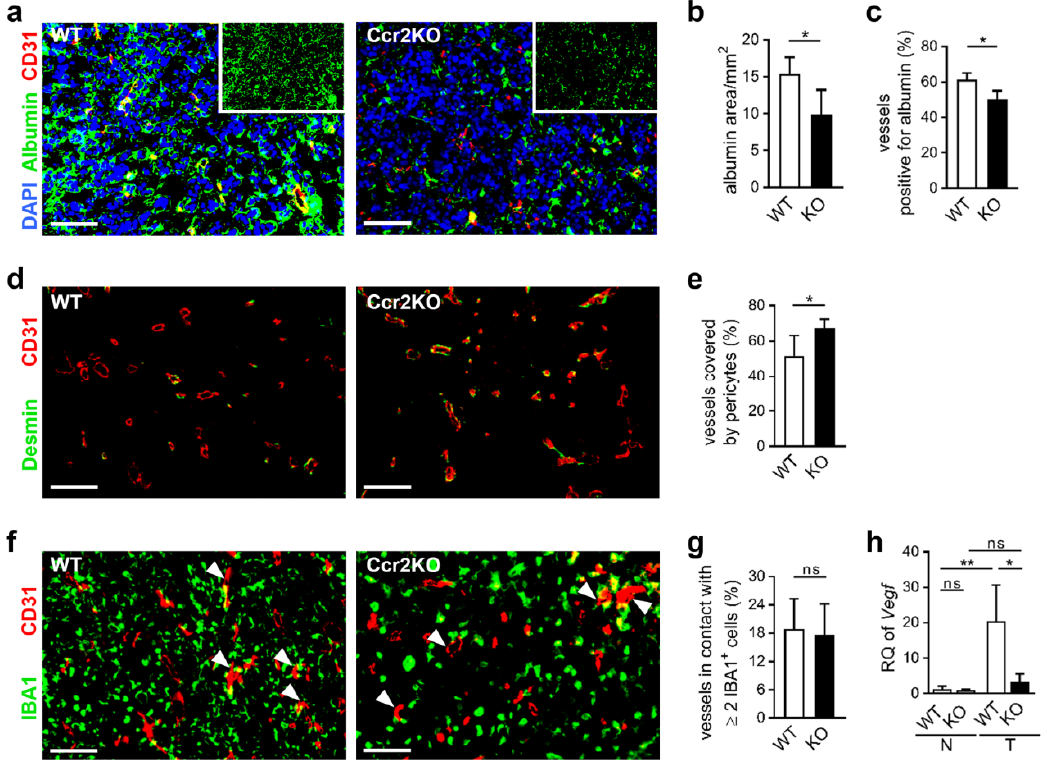
Figure 6. Vascular integrity is improved of glioma grown in Ccr2 -deficient mice. ( a,d,f ) Representative images of brain tumor sections of WT and Ccr2KO mice (d21) stained for CD31 and albumin (a), Desmin (d) or IBA1 (f) are depicted. Arrowheads indicate vessels in contact with IBA1 + cells (f). Scale bars 100 µm. ( b,c,e,g ) Graphs present area of albumin staining (b), vessels colocalized with albumin (c), pericyte-covered vessels (e) and vessels interacting with IBA1 + cells (g). * p < 0.05; ns, not significant (unpaired Student’s t -test). ( h ) RT-PCR for Vegf of CD11b + cells (myeloid cells) from naïve (N) and tumor-bearing (T) brain tissues of WT as well as Ccr2KO mice is depicted (d21; n = 3–4). ** p < 0.01; * p < 0.05; ns, not significant (one-way ANOVA and Bonferroni´s multiple comparison test).